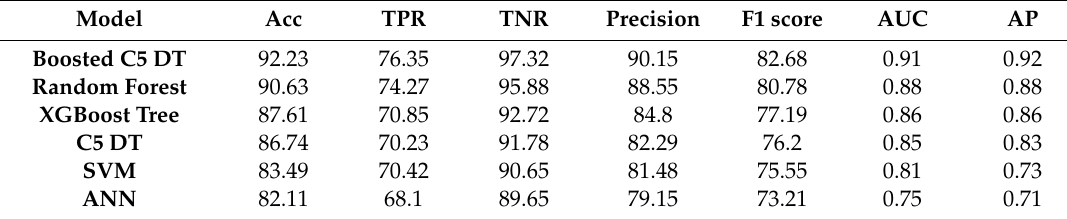
Table 6. Performance evaluation metrics for classifiers before feature extraction and selection process.